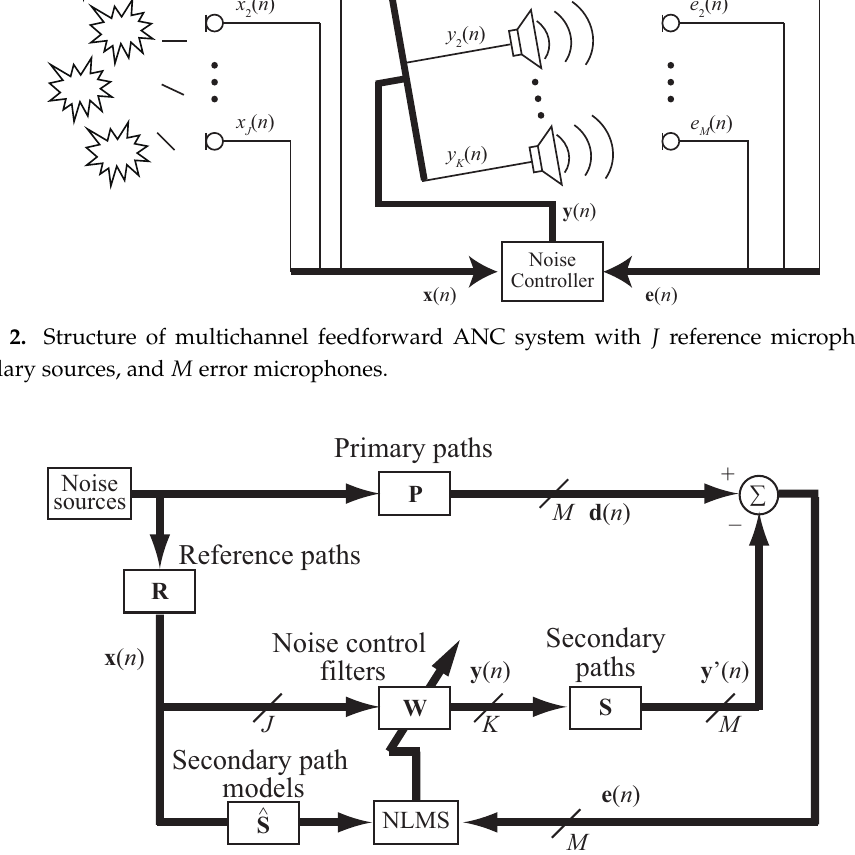
Figure 3. Block diagram of multichannel ANC system with J reference microphones, K secondary sources, and M error